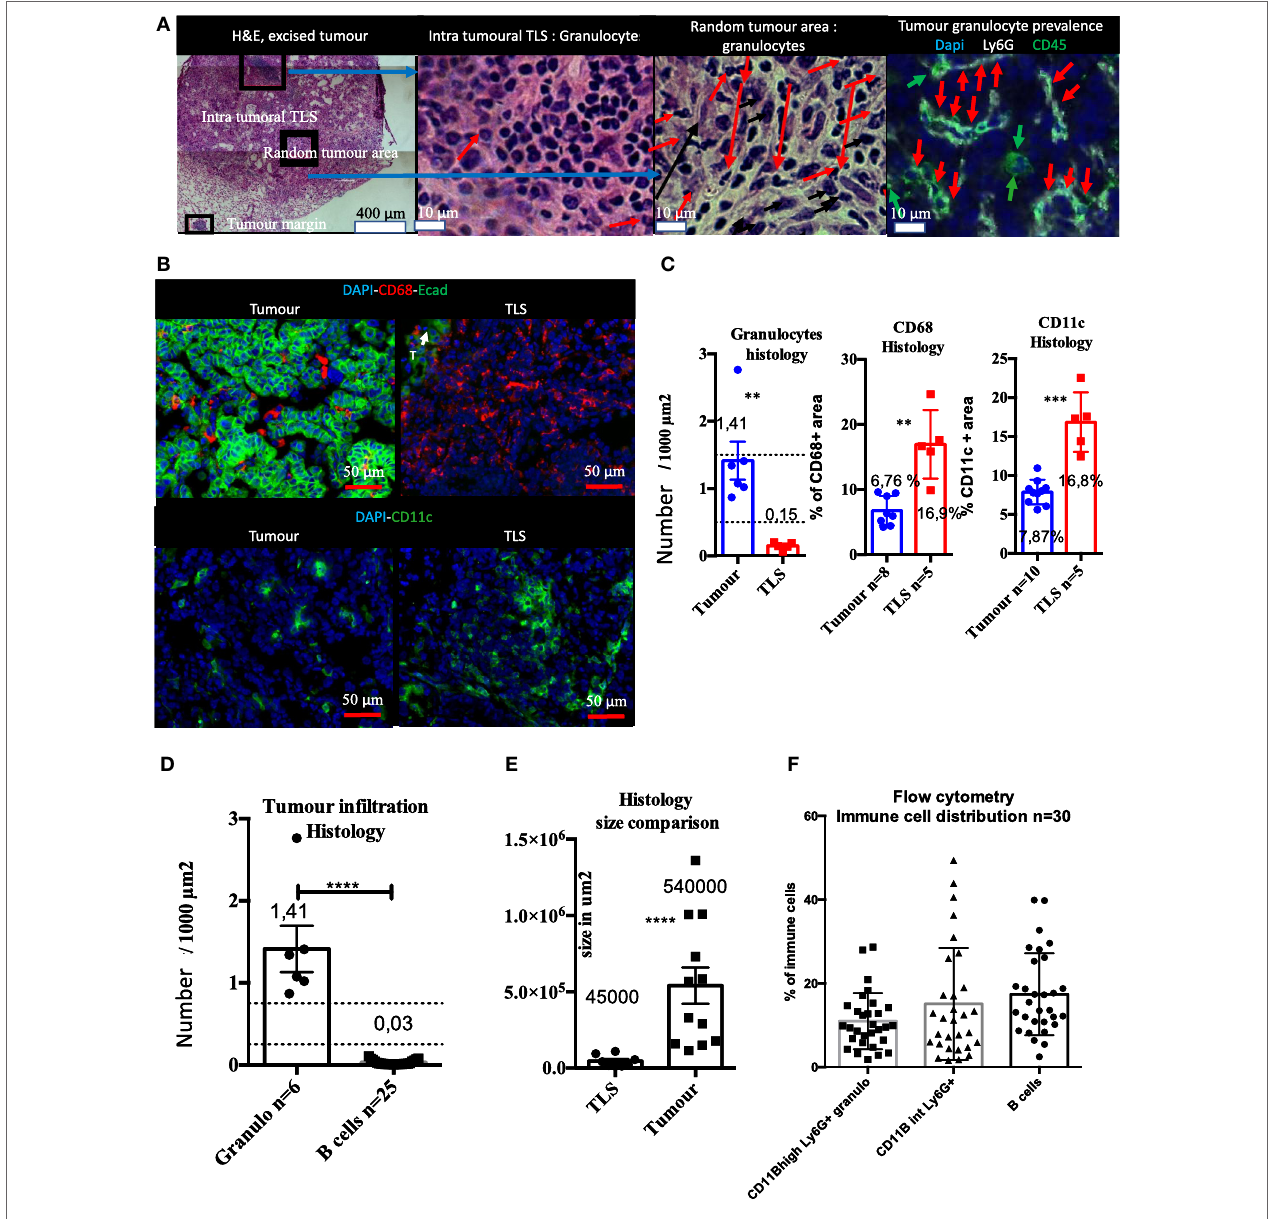
FigUre 5 | Histological and flow cytometry analysis correlation highlights granulocytes as biomarker of intra-tumor immune compartment and B cells as biomarker of tertiary lymphoid structures (TLS). Macro-dissected tumor H&E shows presence of TLS in samples. Granulocytes are almost absent in TLS and very abundant in tumors (a) . CD68 and CD11c + cells that include macrophages, monocytes, and DCs, but not granulocytes, are present in both compartments but display different morphological features (B) . Tumor versus TLS quantification for CD68, CD11c, or granulocytes is shown in (c) . Granulocytes are histologically much more prevalent than B cells in the tumor compartment (D) . Size histological comparison of TLS and tumors is shown in (e) . Strong prevalence of B cells obtained by Flow Cytometry analysis suggests TLS are also analysed with this method (F)